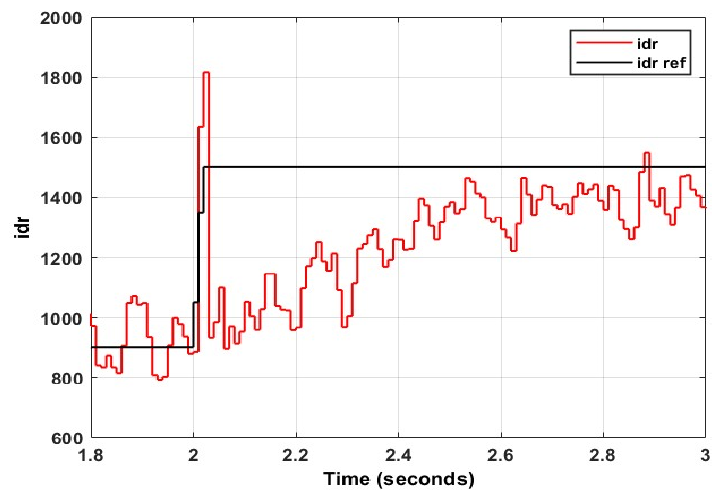
Figure 43. Rotor direct axis current ripple using LQR at 80% dip.